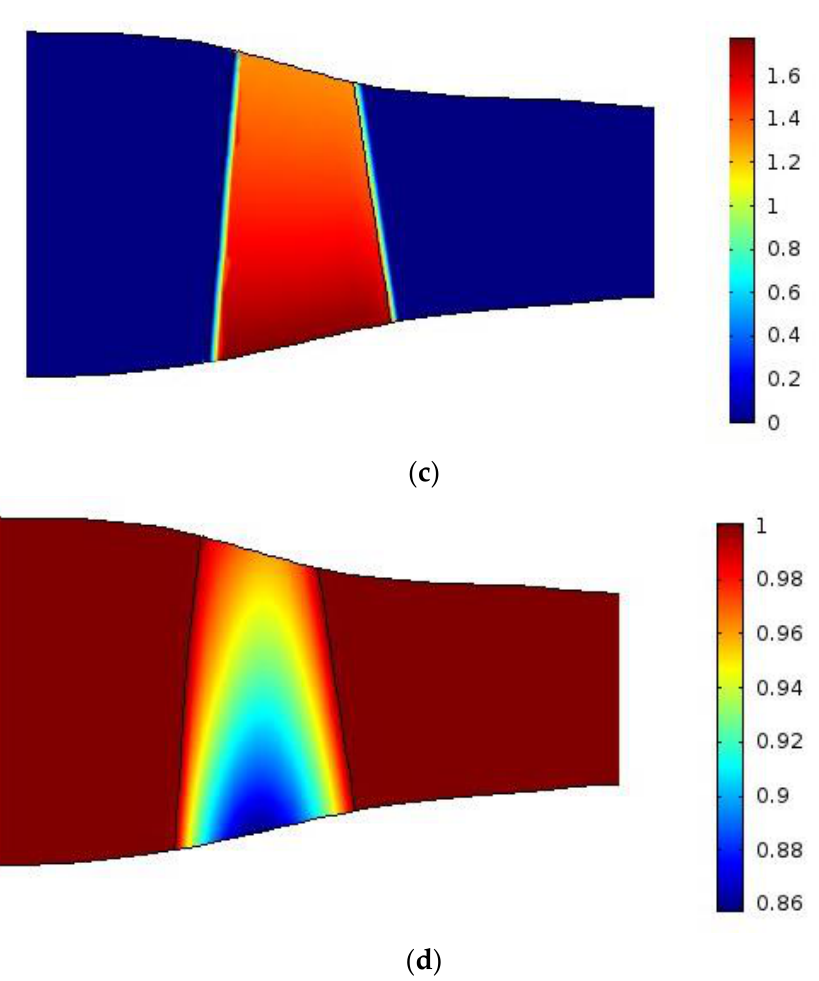
Figure 10. NASA Rotor 37 blade geometry parameters. ( a ) The camber angle α (rad); ( b ) The spacing h (m); ( c ) The solidity σ (1); and ( d ) The blockage b (1).